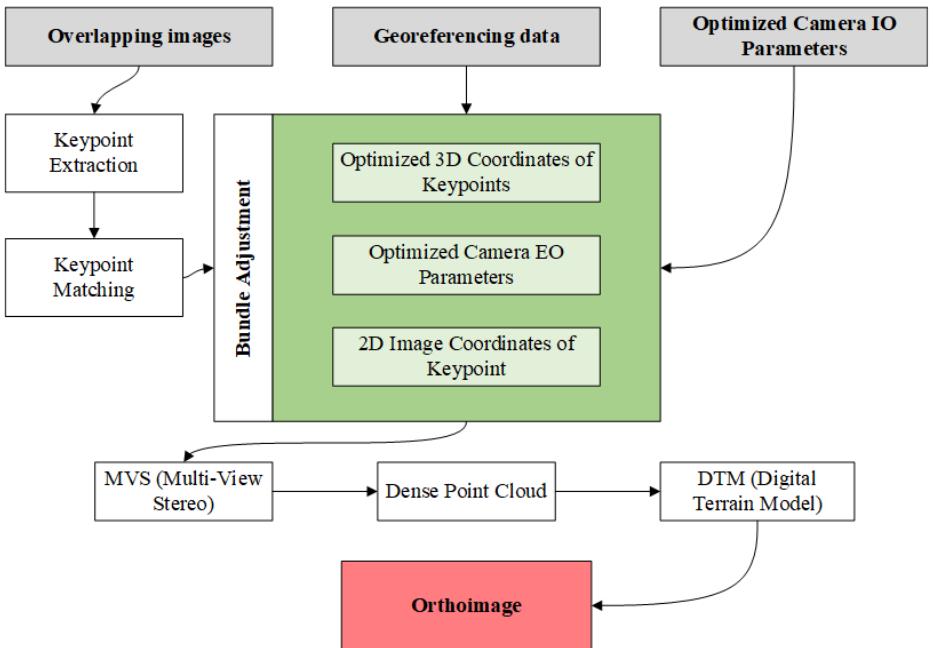
Figure 1. Diagram of the Structure-from-Motion-Multi-View Stereo (SfM-MVS) algorithm’s operation, whose final result is an orthoimage based on [27].